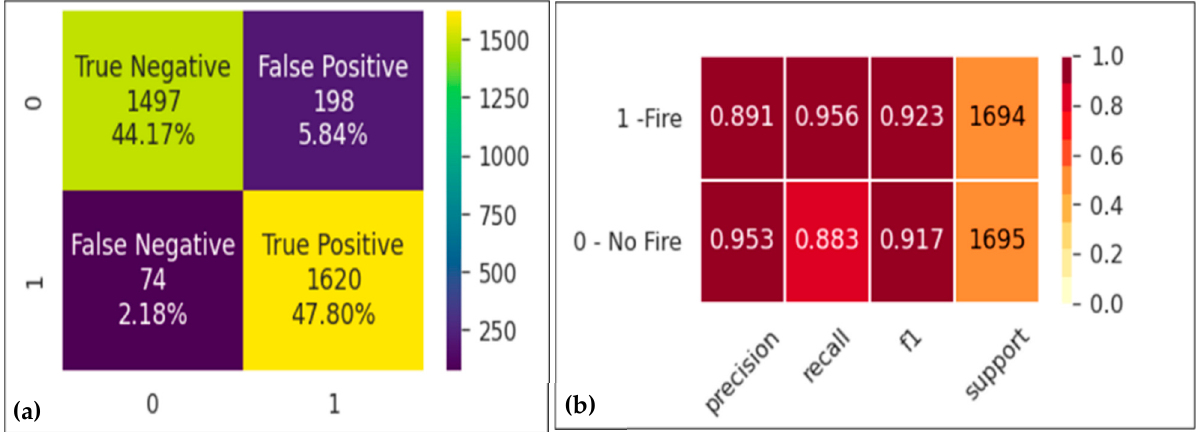
Figure 12. Confusion Matrix ( a ) and Classification report ( b ) of Combined Random forest model . The ROC curve was plotted and evaluated, with the best threshold of 0.478619 and a G-Means of 0.811. The image in Figure 13 shows the best threshold and combined model results with a modified threshold value.